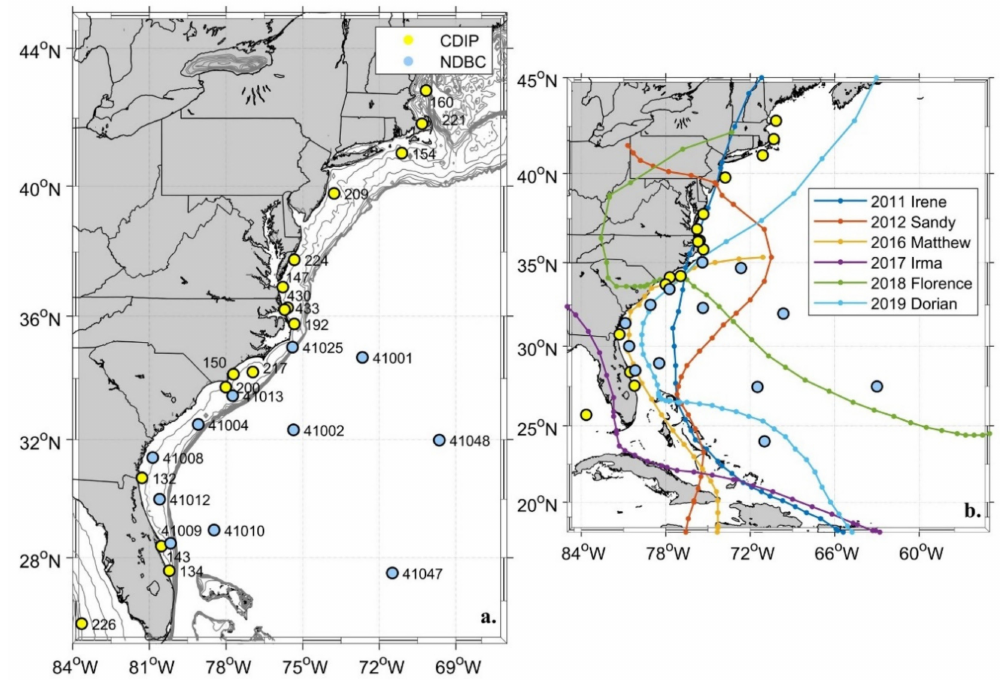
Figure 1. ( a ) Map of the Northern Atlantic Ocean showing CDIP and NDBC locations used in the study and ( b ) buoy location map overlaid with hurricane tracks assessed in this